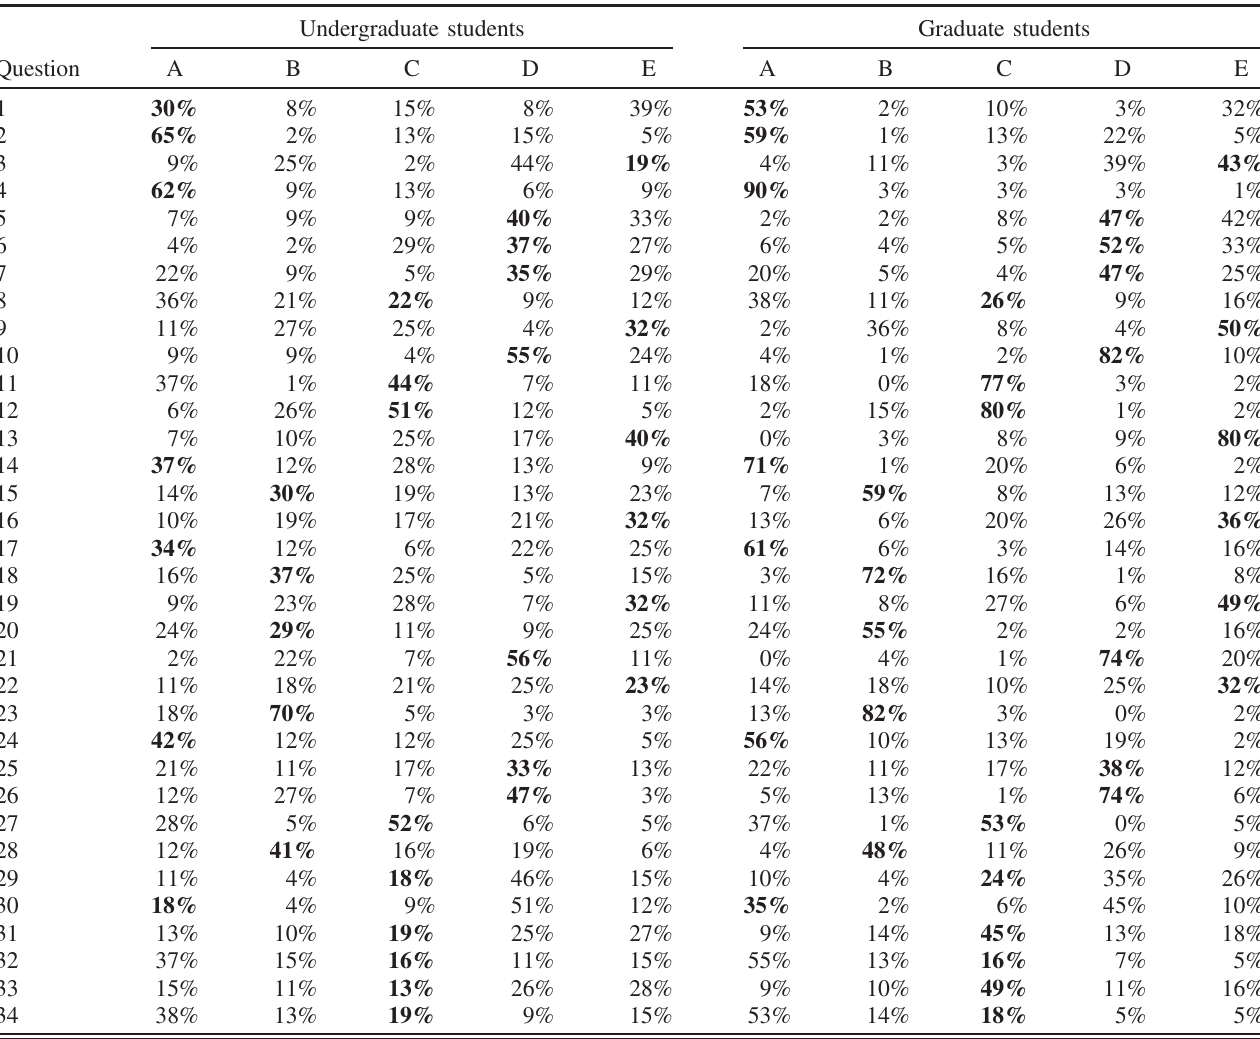
TABLE III. Distribution of undergraduate and graduate student responses to individual questions on the QMFPS. Bolded percentages indicate the correct answer.